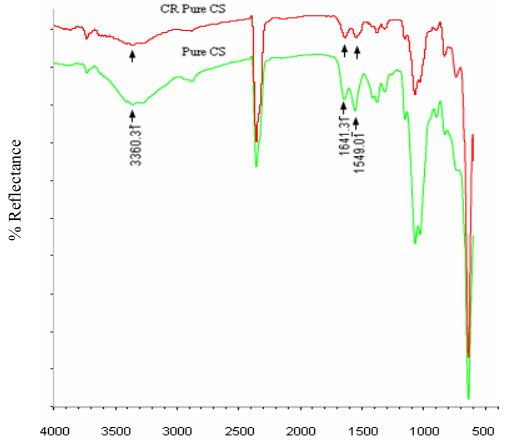
Figure 2. FTIR-ATR spectra of pure chitosan film and its crosslinked